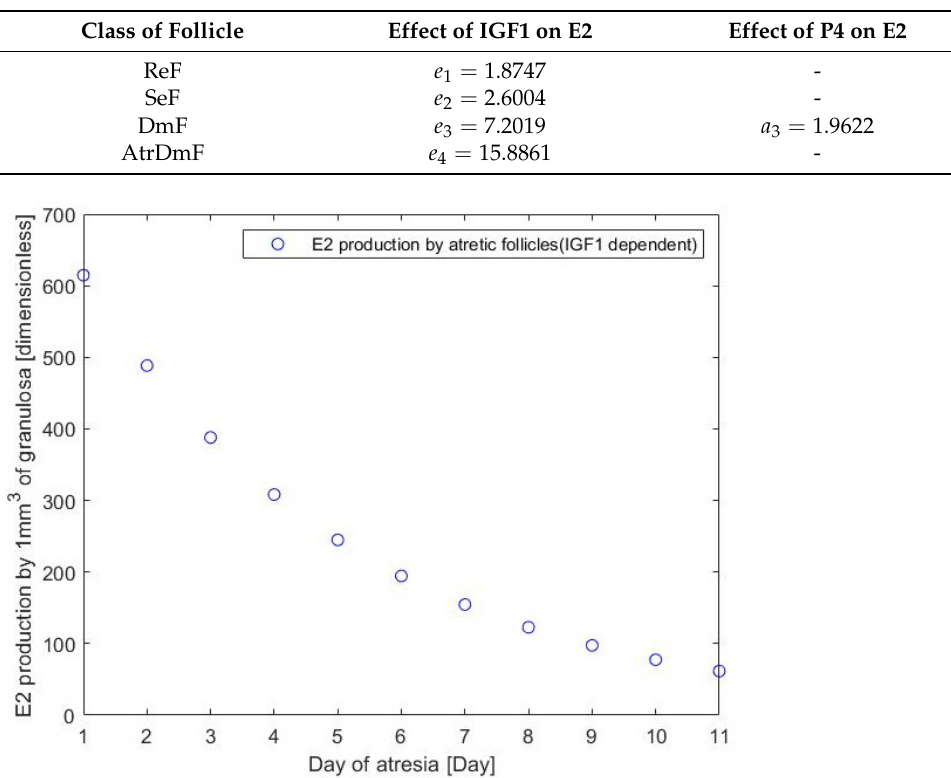
Table 5. Optimised parameter values for Equation (1) describing the effect of IGF1 and P4 on the production of E2 by 1 mm 3 of granulosa cells in different classes of healthy and atretic follicles. These are scaled values (divided by the scaling factors in Table 4).